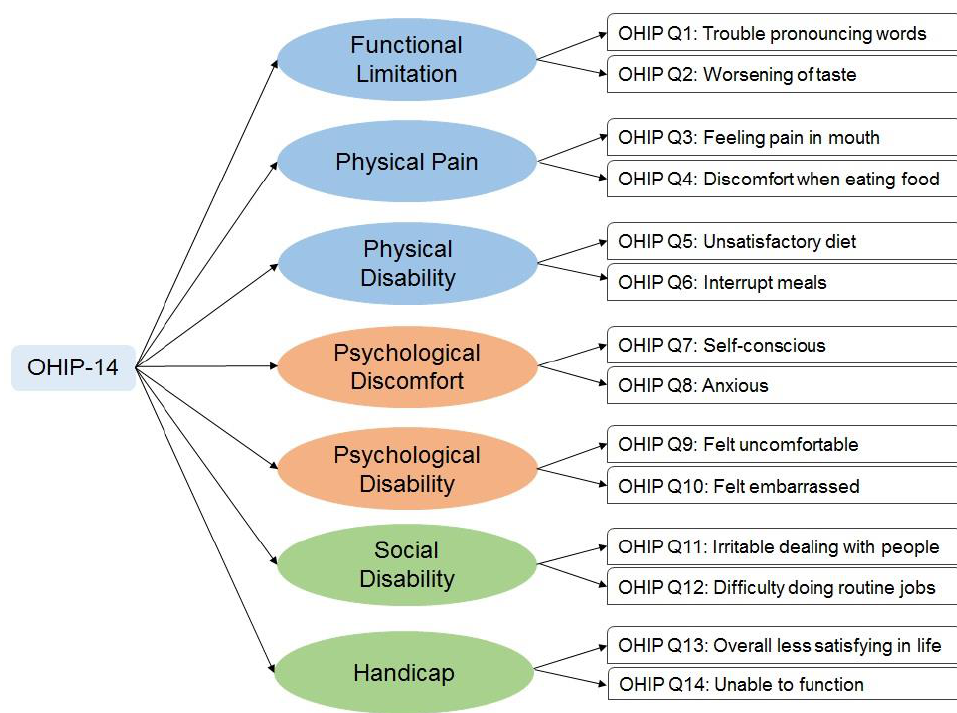
Figure 1. Oral Health Impact Profile-14 (OHIP-14) questions used in the study.